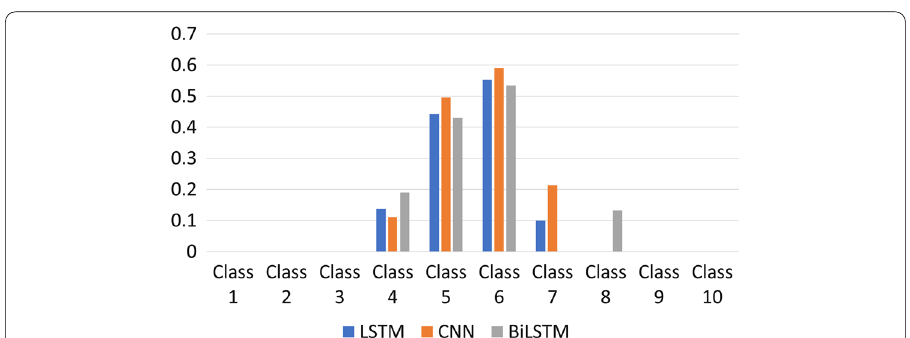
Fig. 14 F1 scores per class for the chosen Magnitude-LSTM, Magnitude-CNN and Magnitude-BiLSTM models